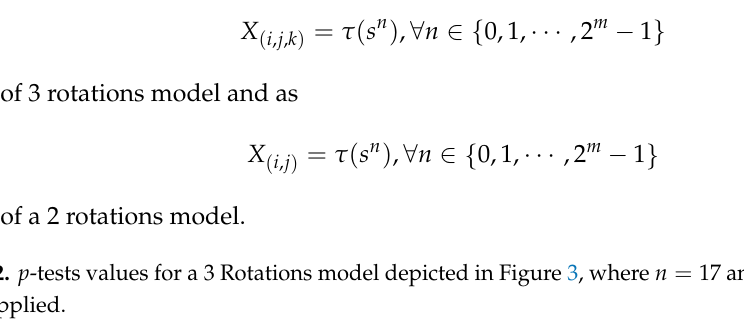
, Rot 6 , Rot 8 have 2 3 1